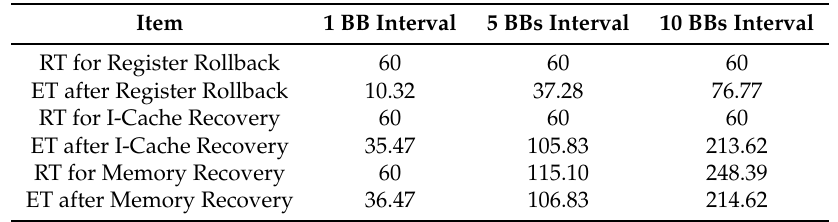
Table 8. Recovery time evaluation (in